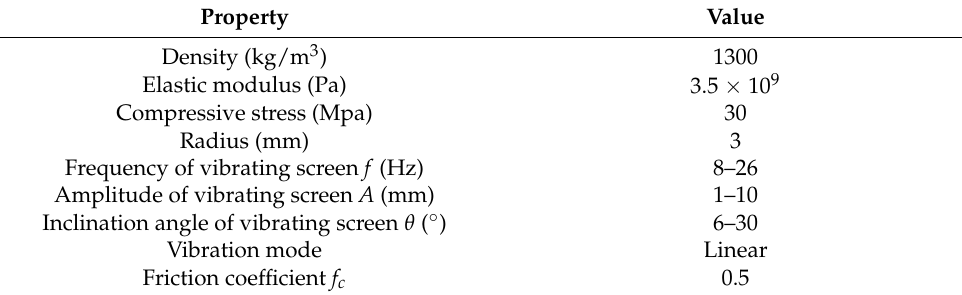
Table 1. Particle mechanical properties and vibrating